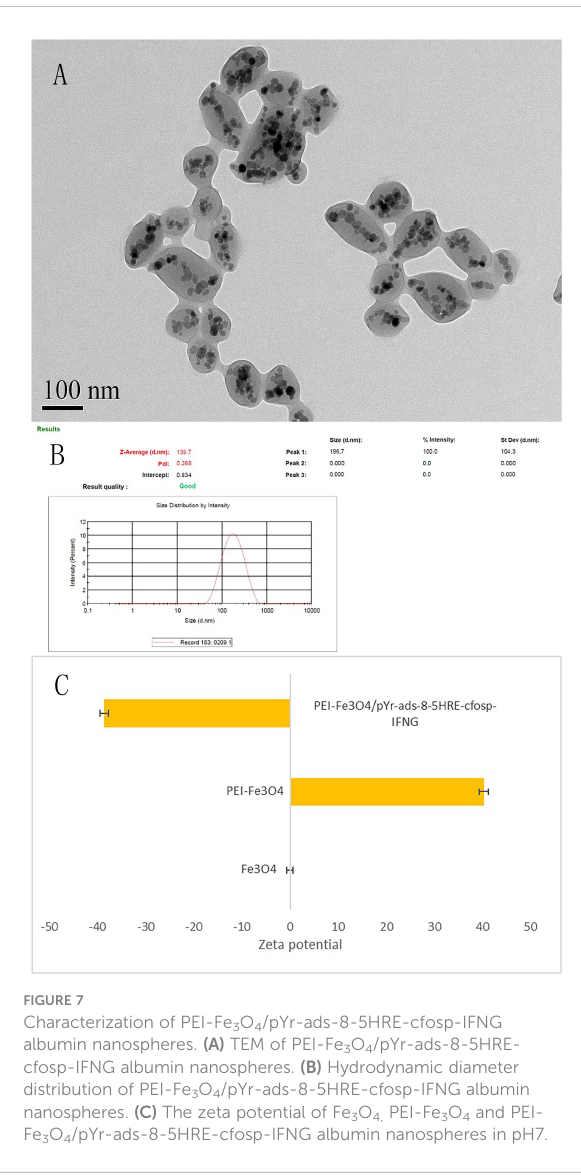
FIGURE 7 Characterization of PEI-Fe 3 O 4 /pYr-ads-8-5HRE-cfosp-IFNG albumin nanospheres. (A) TEM of PEI-Fe 3 O 4 /pYr-ads-8-5HRE- cfosp-IFNG albumin nanospheres. (B) Hydrodynamic diameter distribution of PEI-Fe 3 O 4 /pYr-ads-8-5HRE-cfosp-IFNG albumin nanospheres. (C) The zeta potential of Fe 3 O 4, PEI-Fe 3 O 4 and PEI- Fe 3 O 4 /pYr-ads-8-5HRE-cfosp-IFNG albumin nanospheres in